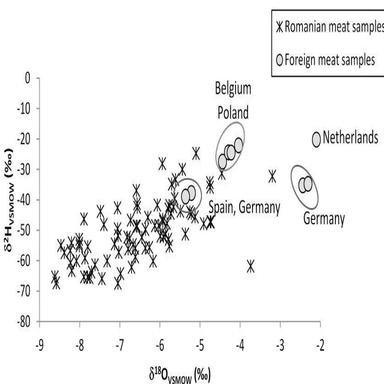
Isotopic composition (δ2 H versus δ18O) for studied meat samples. Areas marked with circles represent a comparison among different countries for meat origin.